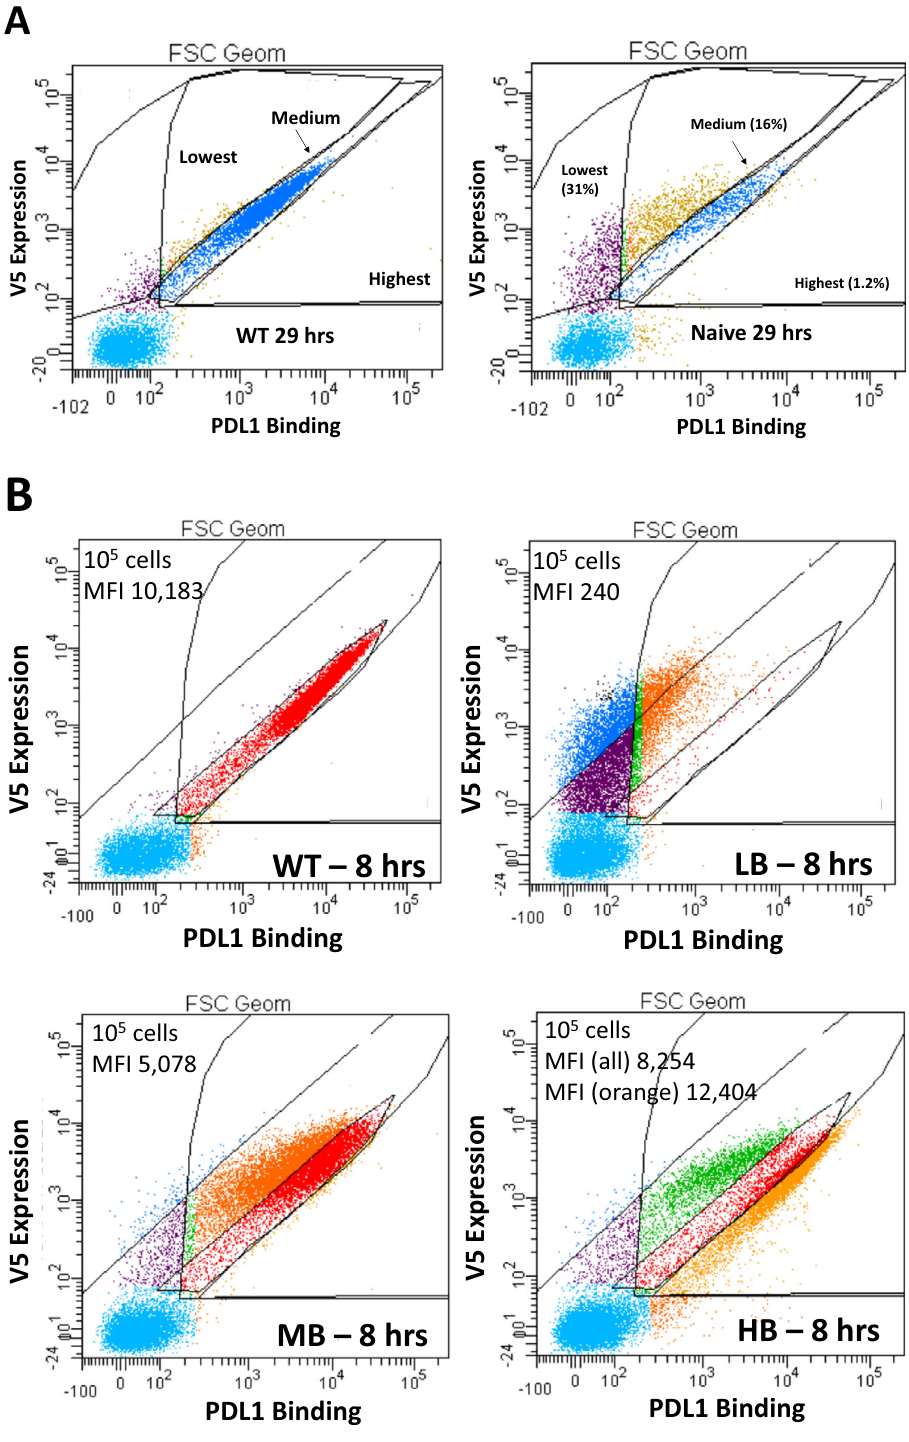
Fig.2|LibrarysortingbyFACS. Sorting of the naive library by FACS and quality assessment of each enriched group by fl ow cytometry. A Sorting of the naive Atezolizumab scFv library on the yeast surface compared to the WT scFv (after 29h of off-rate competition). The right (highest) gate was set to collect mutants withsloweroff-rateswhilethemiddle(medium(bluecells))gatewassetforWT- level off-rates and the left (lowest (purple)) gate set for faster off-rates. The y-axis represents scFv expression (measured by the level of V5 epitope/AF647)